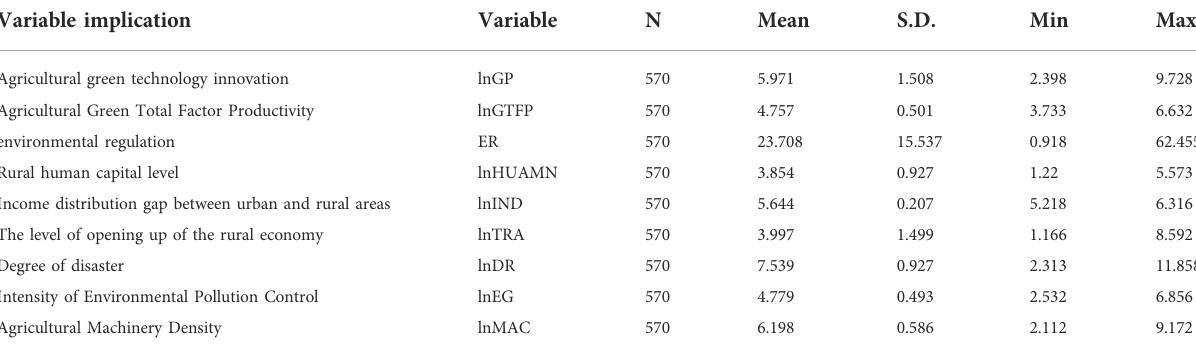
TABLE 1 Descriptive statistics of each variable.